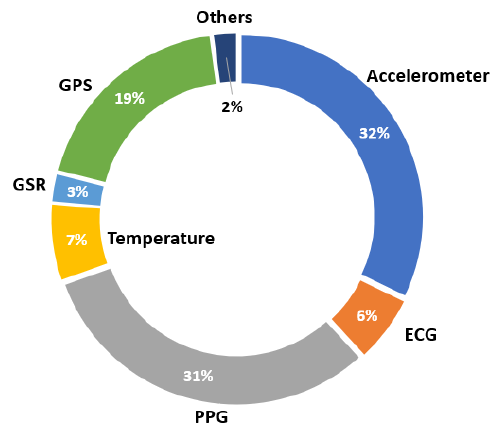
Figure 14. Distribution of sensors used in marketed